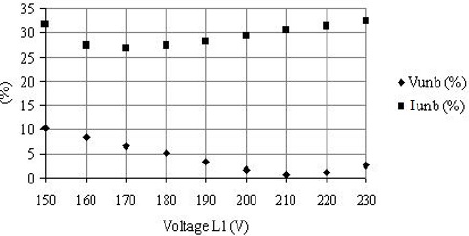
Figure 12. The unbalance factor for voltages V unb and currents I unb depending on supply voltage on phase a (set 3).